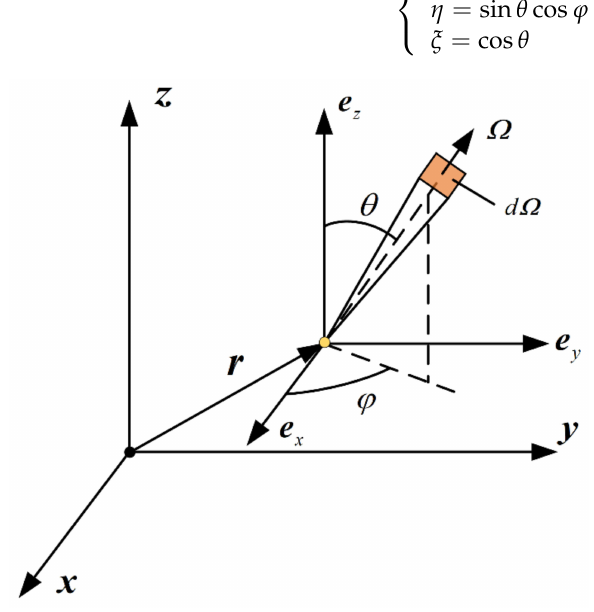
Figure 4. Schematic diagram of photon coordinates in a rectangular coordinate